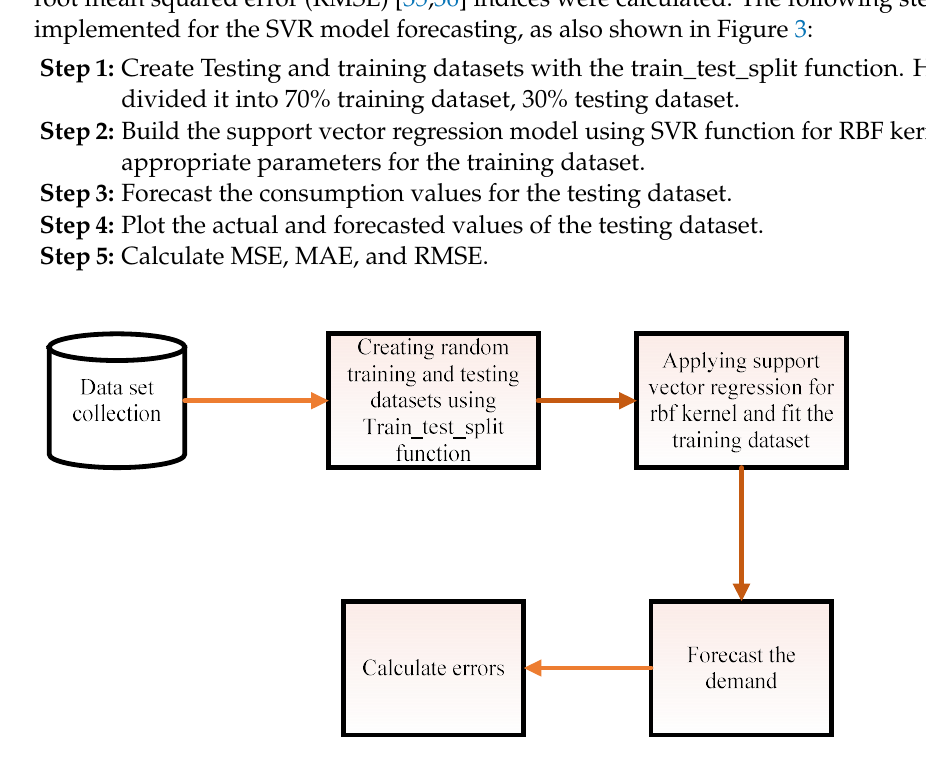
Figure 3. Architecture of support vector regression.